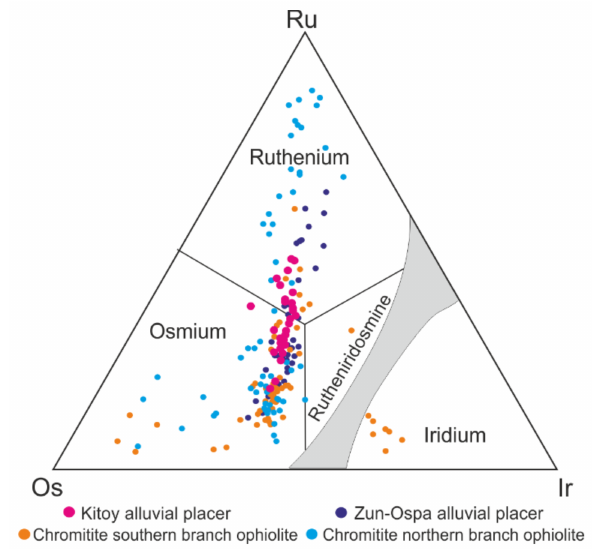
Figure 3. Compositional variations of grains of Os-Ir-Ru alloys from the Kitoy placer (this study), in comparison with Os-Ir-Ru alloys from the Zun-Ospa deposit, East Sayan [30], Os-Ir-Ru alloys from chromitites South and North ophiolite branches [28,29] in terms of the Os-Ir-Ru diagram (at.%). The miscibility gap and nomenclature are based on [47].